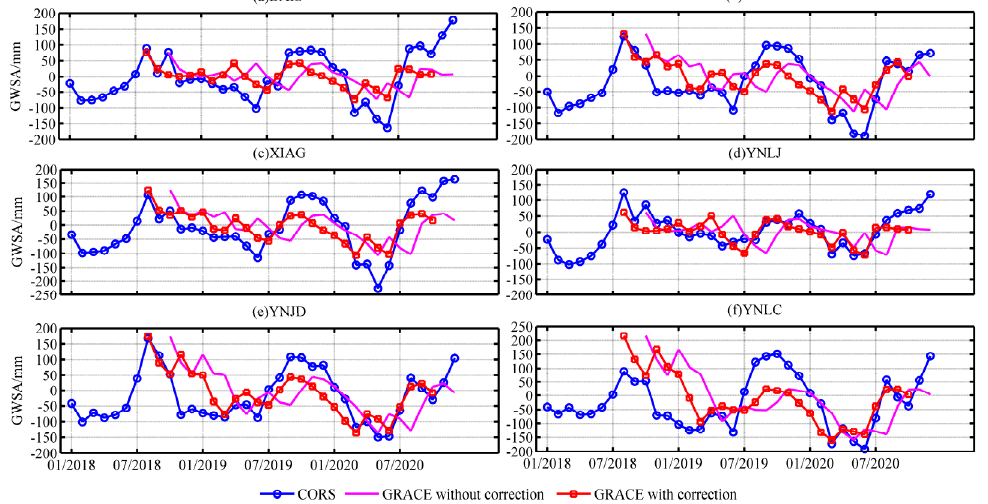
Figure 10. Comparison between CORS and GRACE inverse